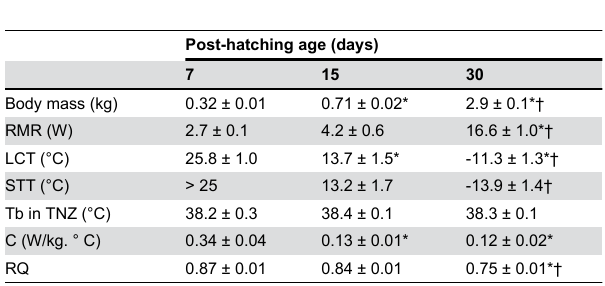
Table 3. Critical temperatures and resting metabolic rates in growing Adélie penguin